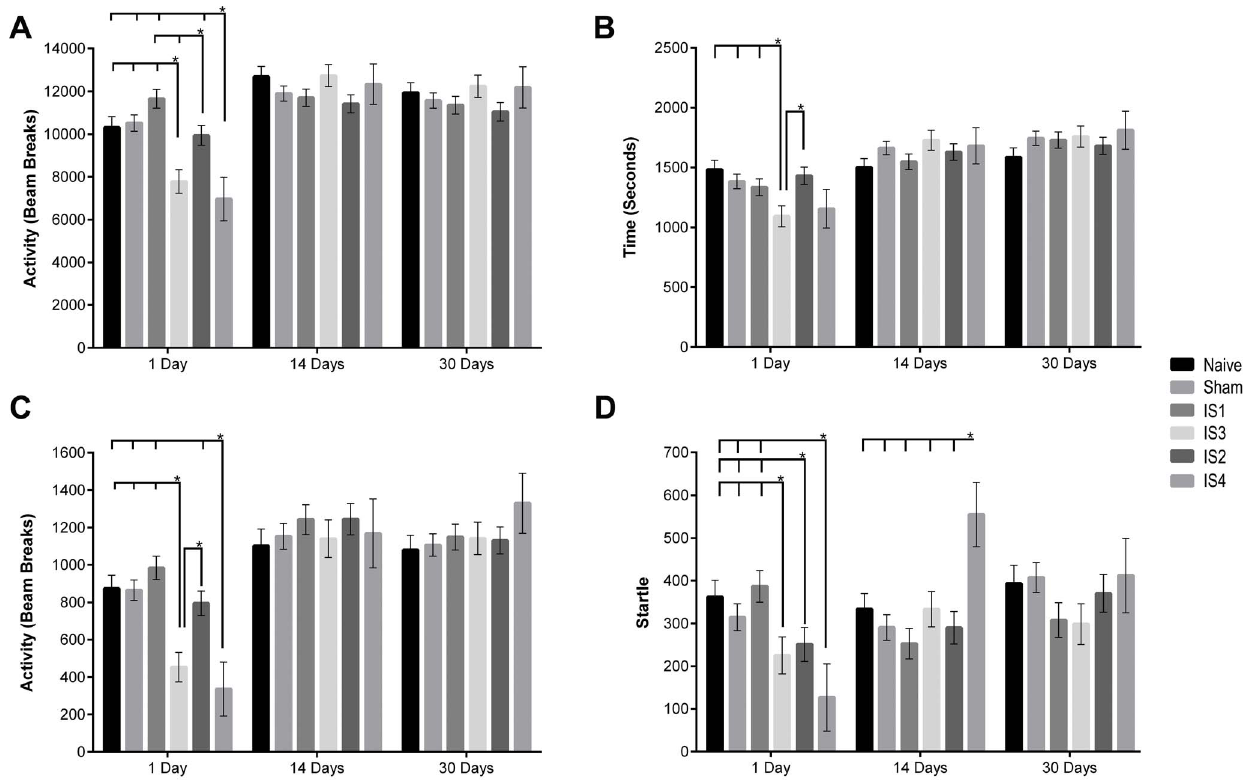
Figure 3. Neurobehavioral Activity. OFL test was conducted to evaluate animals’ various activities in an open field as a measurement of behavioral deficits. Overall, day 1 showed significant reductions in the activities of injured animals as compared to the naı¨ve and sham controls except for the IS1 group, which was not significantly different from that of naı¨ve and sham groups. ( A ) Horizontal activity was evaluated as an indicator of the overall health. Activity was significantly reduced in the IS3 and IS4 groups. Activity in the IS2 group was significantly reduced as compared to the activity of IS1. Activity of IS1 and IS2 groups were not significantly different from the sham group. ( B ) Time spent in the center of the open field was evaluated as an indicator of anxiety-like behavior. Center time of the animals in IS3 and IS4 groups was reduced as compared to the 246 g injury groups ( i.e. , IS1 and IS2), sham and naı¨ve animals. The reduction in activity reached significance in the IS3. ( C ) Vertical activity was measured as an indicator of depression-related behavior. Vertical activity of the injured animals was significantly less than that of the sham and naı¨ve animals except the IS1 group. * P value , 0.05. ( D ) Startle response was measured as an indicator of emotional distress and potential sensory gating impairments. Startle responses of all injured groups, except the IS1 group, were reduced when compared to naı¨ve and sham groups at day 1 post injury. There were no differences between groups at days 14 and 30 post injury, except in the IS4 group where the startle response was significantly higher than all other groups at day 14 post injury. Values are expressed as Mean 6 SEM. * P value , 0.05.